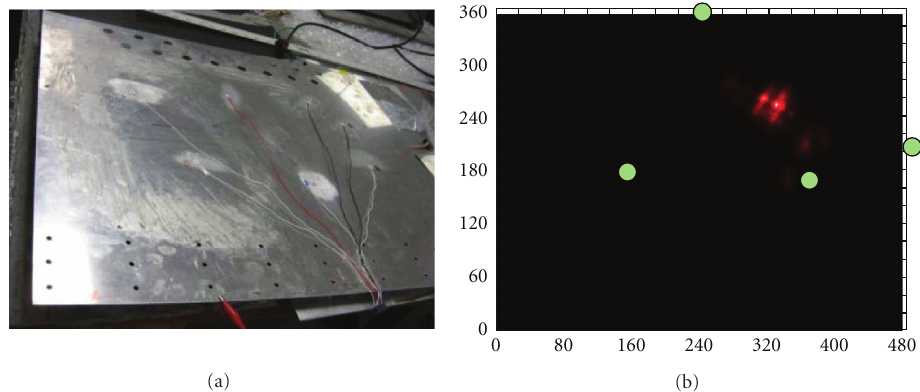
Figure 12: Array imaging for crack growth detection. (a) Test specimen and sensor network; (b) array imaging of a hairline crack of 18 mm length. Sensor locations are marked as green face